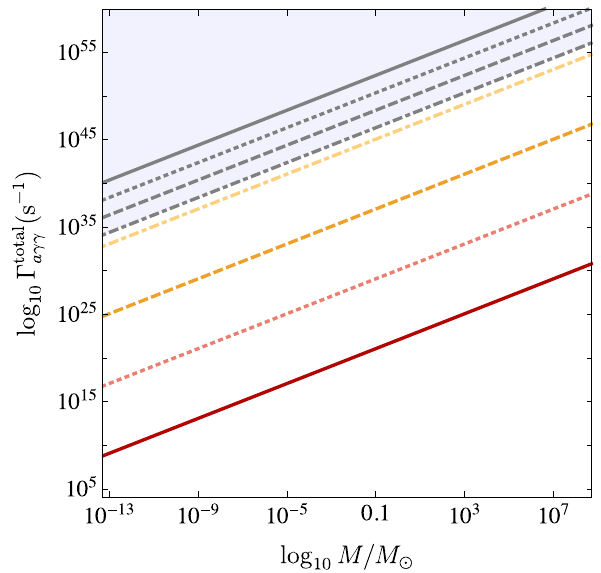
Fig. 2 Total decay rate (cid:3) total a γγ as a function of halo mass M in units of the solar mass M (cid:4) for different values of the particle mass m (see Fig. 1). The grey-shading indicates the corresponding regions in which the halos would have already decayed by now. The different black lines correspond to the colored lines with the same line style which can easily be computed for,